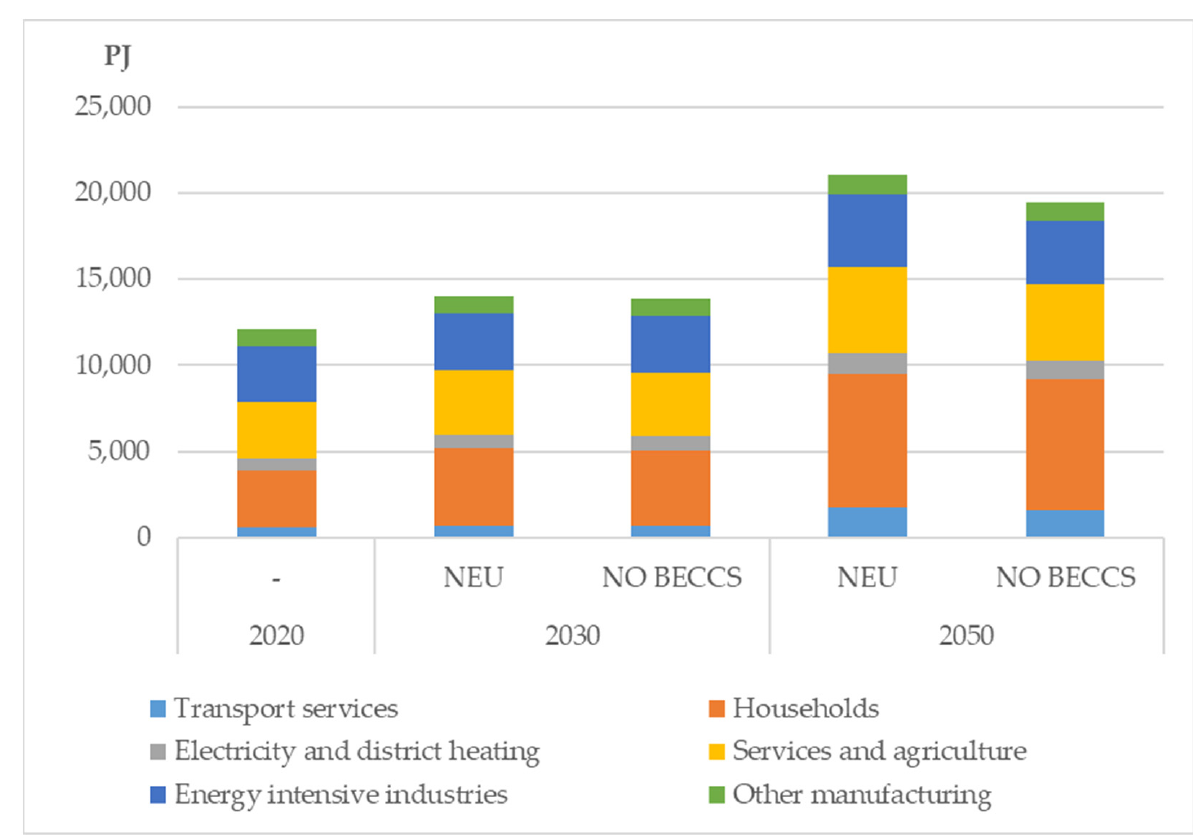
Figure 7. Electricity demand in the considered scenarios (in PJ). Source: own calculations based on d-PLACE model results.